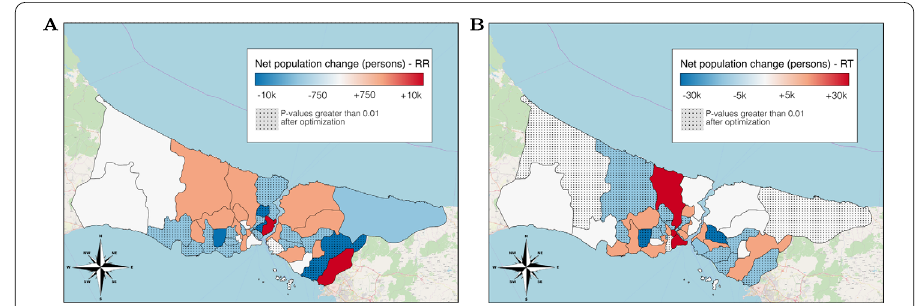
Figure 6 Maps of the results of the optimisation, for the Refugee–Refugee and Refugee–Turkish networks respectively. Districts are coloured in a gradient according to their relative change in population. Districts where Turkish and Refugee communication patterns were harmonised ( p -value from χ 2 test indicating no significant difference) have a dotted